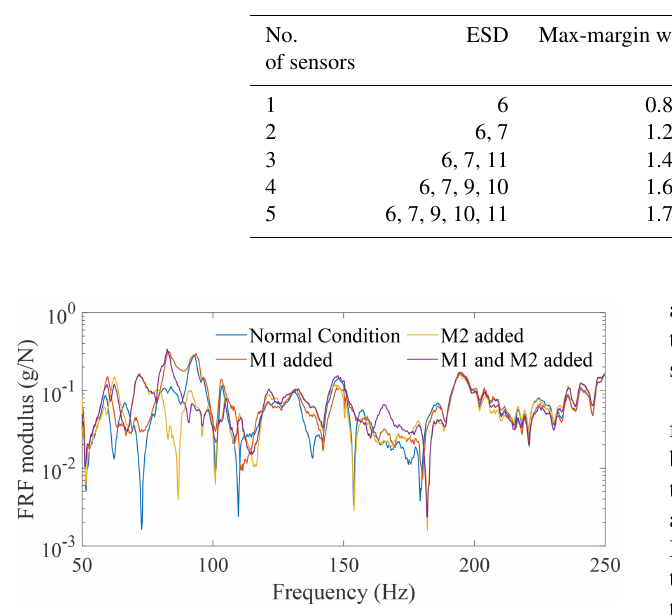
Table 2. Optimal sensor combination designed for the M2 case detection and corresponding max-margin widths.